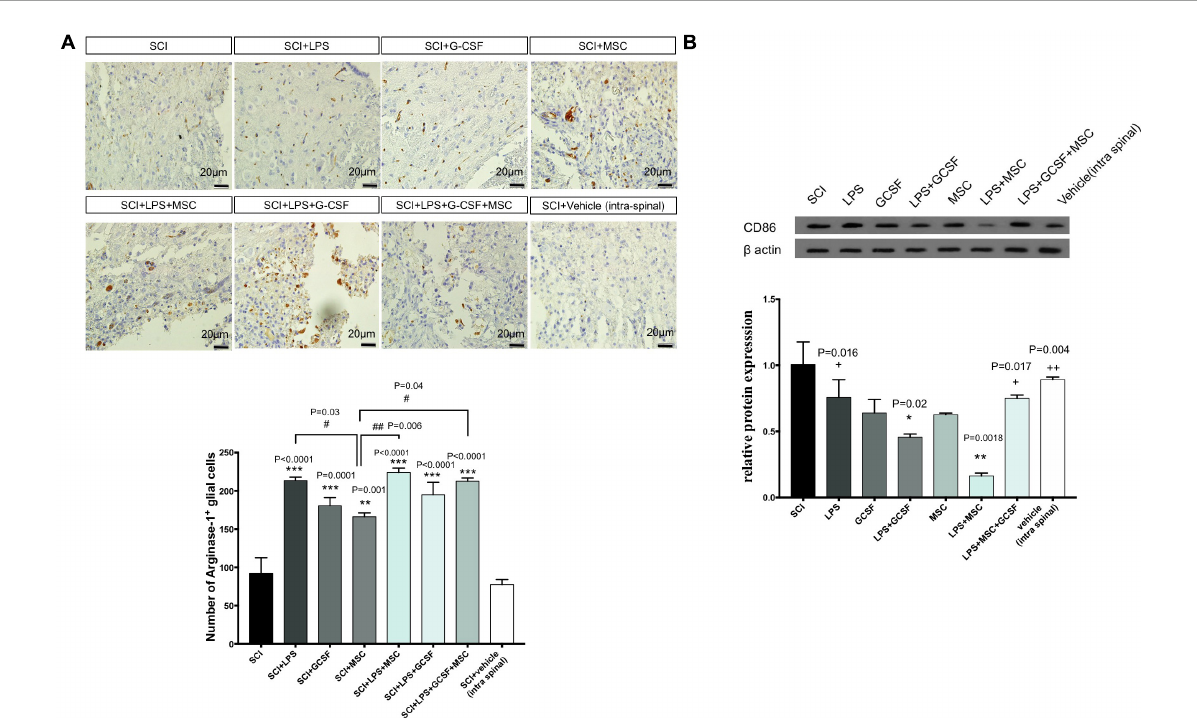
FIGURE8 Combination therapy regulates the polarization of macrophage in the lesion center. (A) Immunostaining for ARG-1 (as M2 macrophages) performed in the lesion center of spinal cords at 7 dpi from each group of rats (scale bar, 50 µ m). (B) The protein expression level, determined by Western blot analysis, in the injured spinal epicenter of SCI rats at 7 dpi for each group of rats. Data are presented as the mean ± SEM, n = 3 independent experiments. Significant differences between groups are indicated as * P < 0.05, ** P < 0.01, and *** P < 0.001 versus SCI. # versus MSC. + versus LPS + MSC. # P < 0.05, ### P < 0.001 versus SCI + MSC, + P < 0.05, ++ P < 0.01 versus LPS +